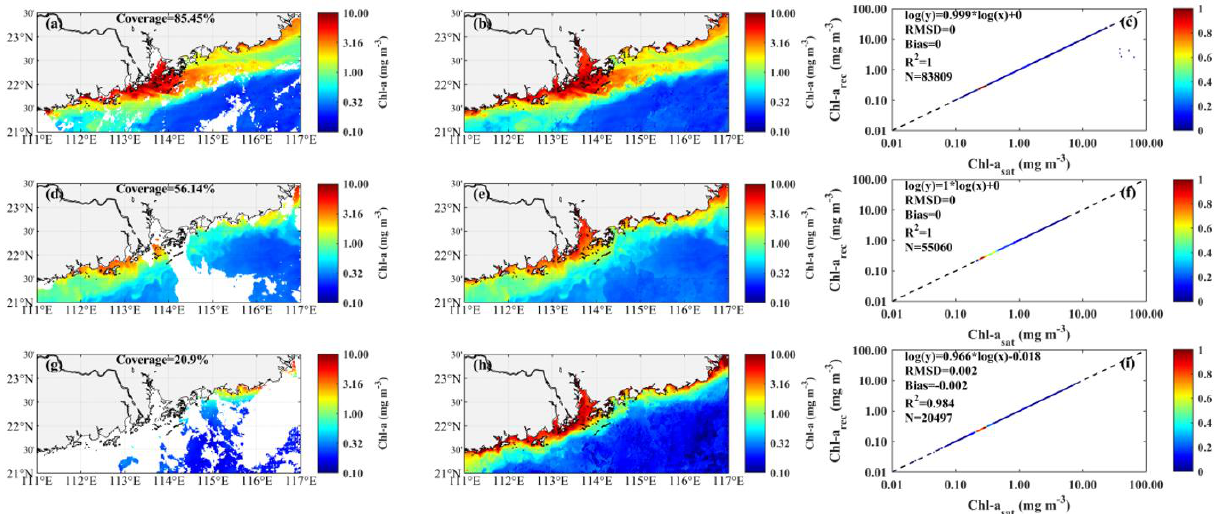
Figure 6. Daily reconstruction of the images acquired on 6 July 2011, 30 September 2019, and 13 August 2020. ( a , d , g ) Satellite−derived C chla , ( b , e , h ) network reconstructed C chla . ( c , f , i ) Scatter plots between C chla-sat and C chla-rec .